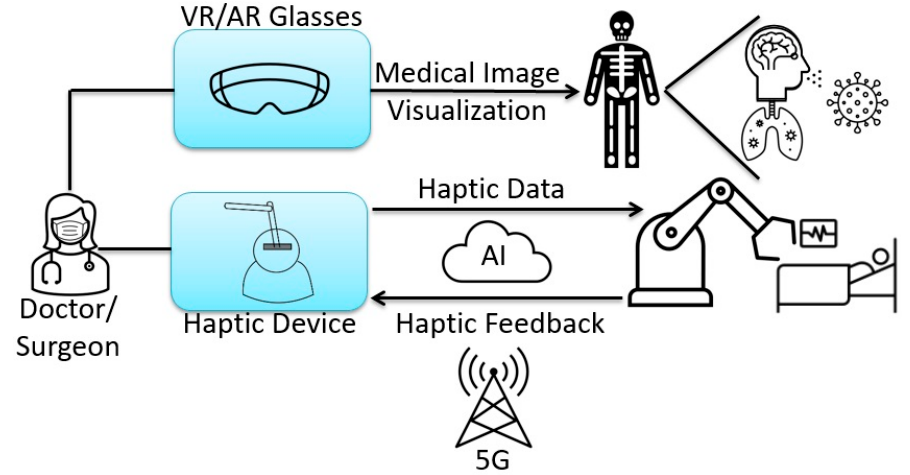
Figure 3. Medical image visualization with AI-based haptic interaction.